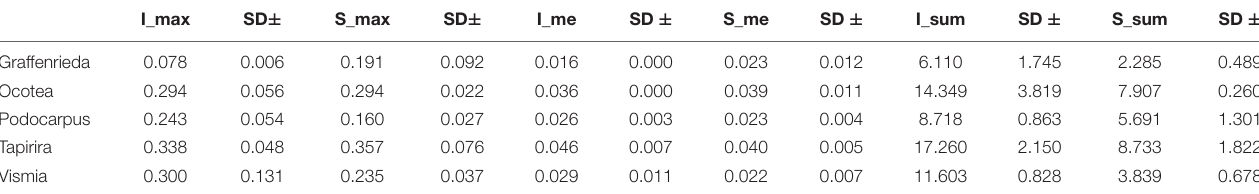
TABLE 3 | Species specific differences in growth